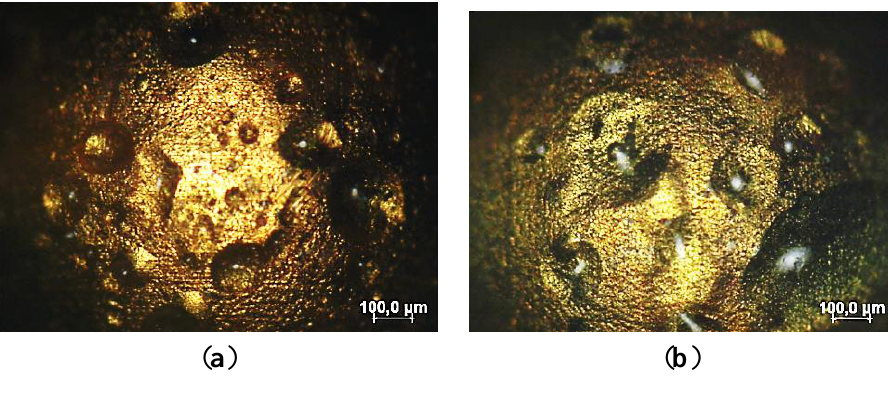
Figure 15. ( a ) Comparison of contact surface with; and ( b ) without SAMs (AUTRONEX™ Nano 104S) after corrosion test, thickness of gold coatings 0.4 μm, sample size B.